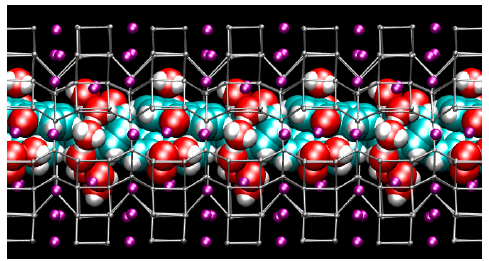
Figure 3. Structure of the hydrated ZL/1.5FL model at P amb —(side view of the 12 MR channel ‖ [001] axis [56]). Tetrahedral atoms (T = Si, Al) of the zeolite L framework are represented as grey stick-and-ball. K + = purple spheres. Water and fluorenone atoms are depicted in van der Waals representation (cyan = C, red = O, white = H) to highlight the close-packing arrangement of guest species inside the zeolite L nanochannel.